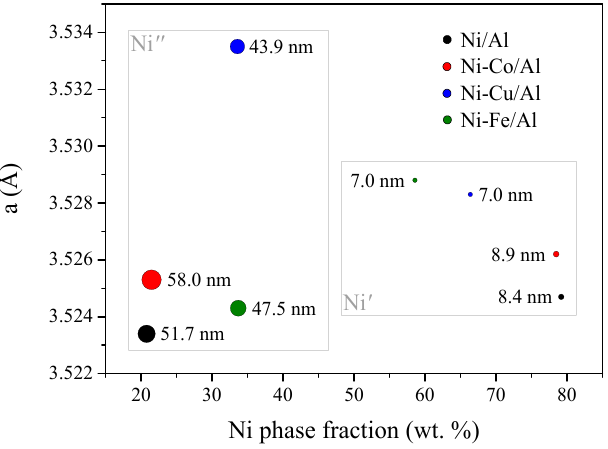
Figure 3. Crystallite sizes (in nm), lattice constants and Ni’ and Ni” fraction percentages of Ni or Ni x Do 1 − x alloy (Do = Co, Cu or Fe according to the catalyst) of the reduced catalysts.